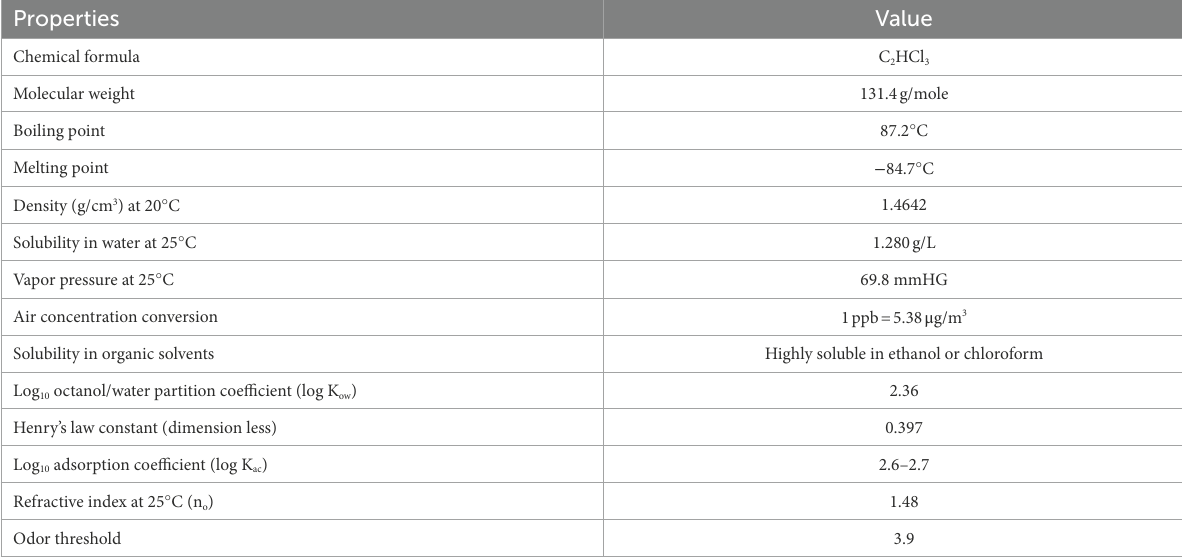
TABLE 1 Physicochemical properties of